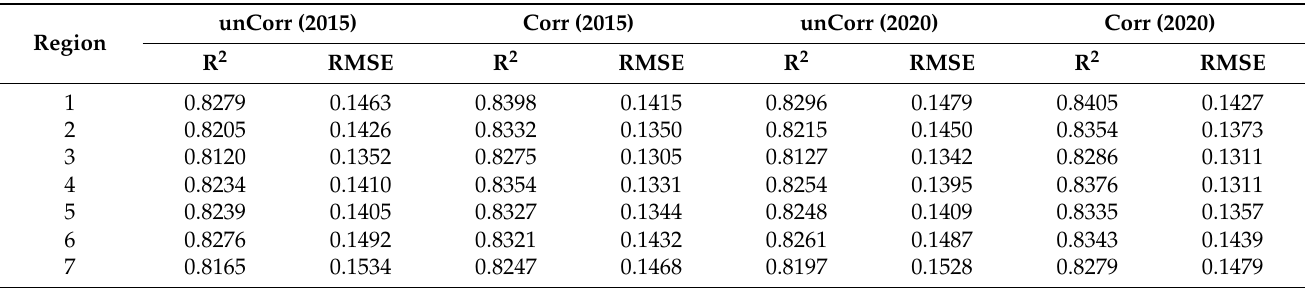
Table 5. Transferability results from uncorrected and corrected.